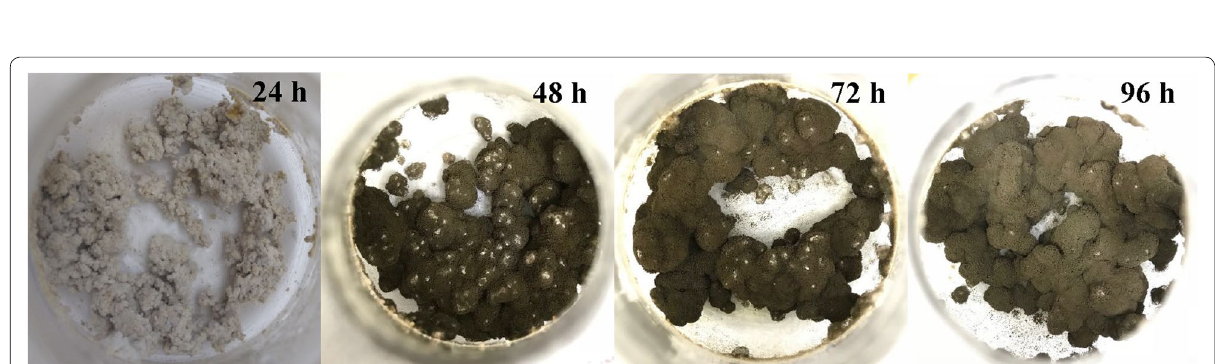
Fig. 2 SSF after 24, 48, 72 and 96 h using lentil flour as the substrate and A. niger LBA02 as the inoculum to obtain extracts with antioxidant and antidiabetic